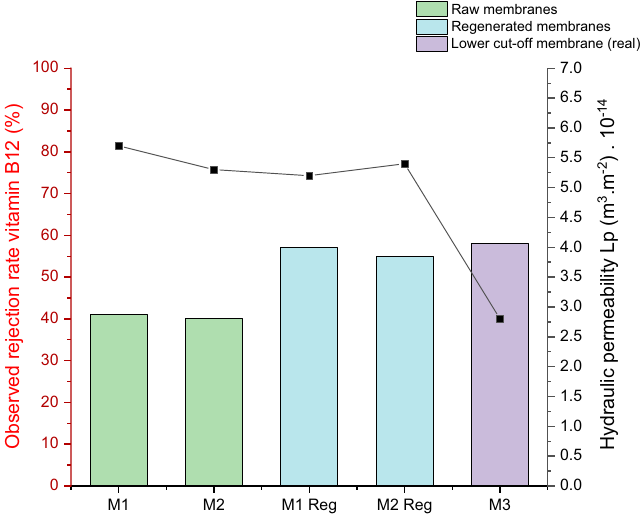
Figure 1. Initial membrane performances: hydraulic permeability Lp (point) and selectivity (columns) for the studied membranes (TAMI membranes, commercial cut-off 1